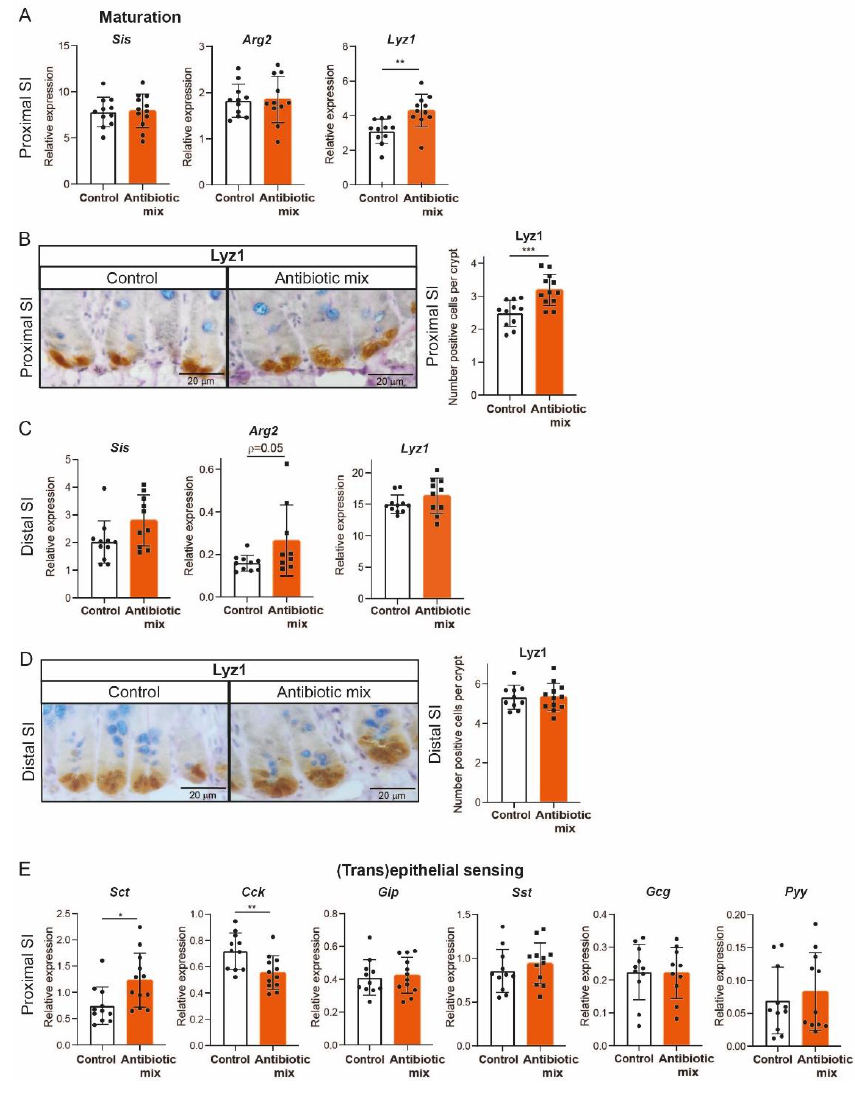
Figure 3. Antibiotics in early life lead to higher number of Paneth cells and few changes in enteroendocrine markers in the proximal small intestine. ( A ) Whole tissue real-time qPCR analysis of adult brush-border enzymes Sis and Arg2 and of Paneth cell marker Lyz1 in proximal small intestine. Relative expression to reference genes Rpl4 and Ppib. Sis: n = 11 control mice, n = 12 AB-treated mice; Arg2: n = 11 control mice, n = 11 AB-treated mice; Lyz1: n = 11 control mice, n = 10 AB-treated mice. ( B ) Immunohistochemistry of lysozyme-1 in proximal small intestine, n = 11 control mice, n = 12 AB-treated mice. (Scale bars, 20 µm.) ( C ) Whole tissue real-time qPCR analysis of adult brush-border enzymes Sis and Arg2 and of Paneth cell marker Lyz1 in distal small intestine. Relative expression to reference genes Rpl4 and Ppib. Sis: n = 11 control mice, n = 10 AB-treated mice; Arg2: n = 10 control mice, n = 9 AB-treated mice; Lyz1: n = 11 control mice, n = 10 AB-treated mice. ( D ) Immunohistochemistry of lysozyme-1 in distal small intestine, n = 10 control mice, n = 12 AB-treated mice (Scale bars, 20 µm.) ( E ) Whole tissue real-time qPCR analysis of enteroendocrine markers Sct, Cck, Gip, Sst, Gcg, and Pyy in proximal small intestine. Relative expression to reference genes Rpl4 and Ppib. Sct, Cck, Gip, Sst: n = 11 control mice, n = 12 AB-treated mice. Gcg: n = 11 control mice, n = 10 AB-treated mice. Pyy: n = 11 control mice, n = 11 AB-treated mice. Statistical analysis was performed by one-tailed unpaired t -test or by Mann–Whitney test when data were not normally distributed as assessed by D’Agostino and Pearson normality test (Sct). Error bars indicate the mean ± SD. Levels of significance are indicated (* p < 0.05, ** p < 0.01, *** p <